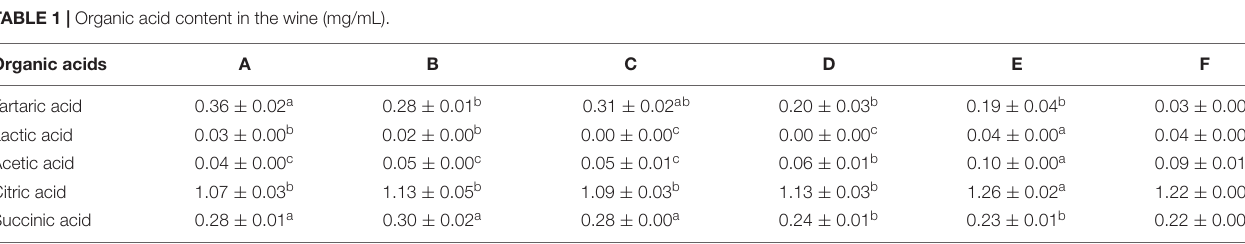
FIGURE 1 | Change of physicochemical indexes in different fermentation time: total sugar (purple), ethanol (red), total acid (orange), and pH (blue) (for interpretation of the references to color in this figure legend, the reader is referred to the Web version of this article). TABLE 1 | Organic acid content in the wine